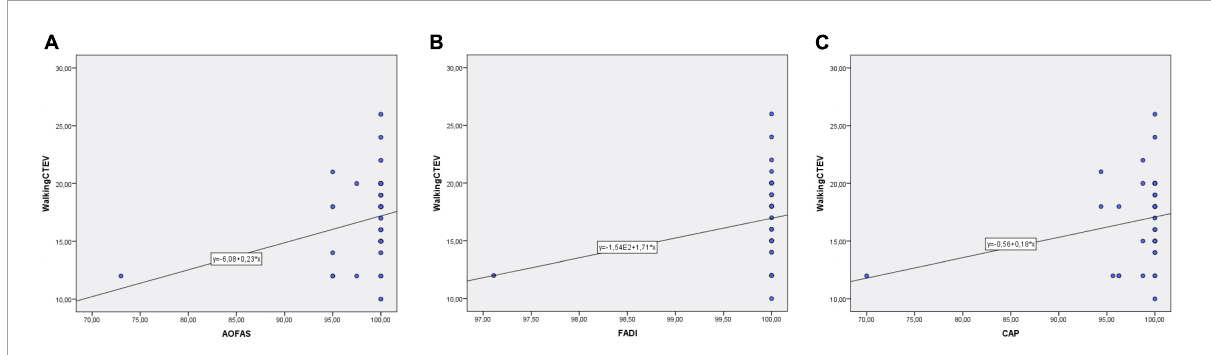
FIGURE7 (A) Correlation between independent gait and CAP Score. (B) Correlation between independent gait and AOFAS. (C) Correlation between independent gait and FADI